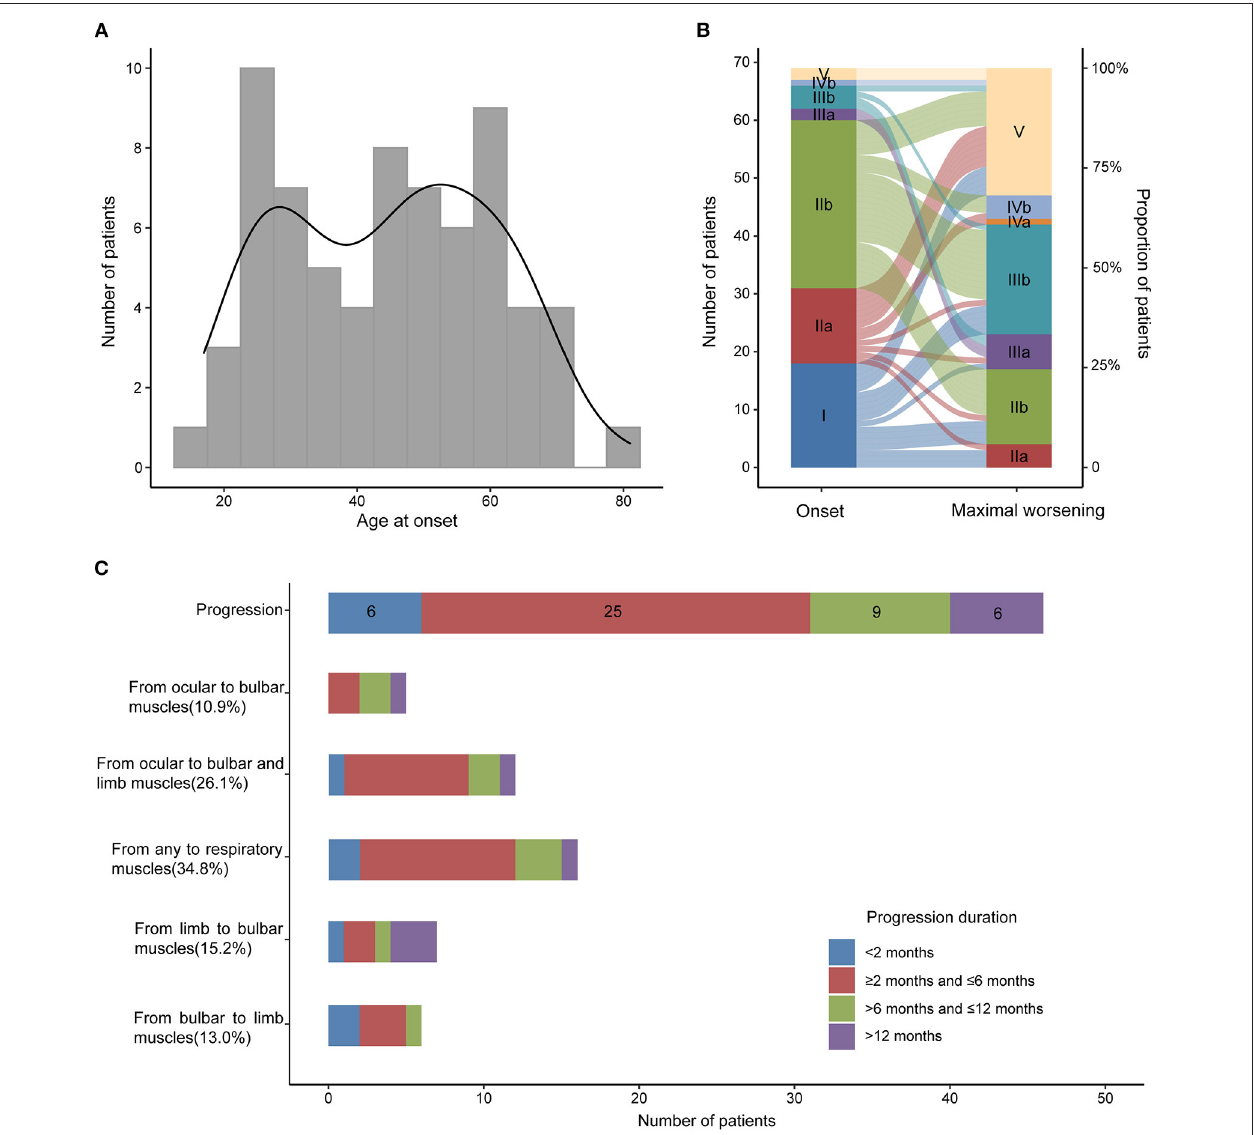
FIGURE 2 | Age at onset, MGFA classification at the onset and maximal worsening and disease progression in MuSK-MG. (A) Age at onset of 69 MuSK-MG patients in our cohort; (B) MGFA classification at the onset and at maximal worsening during the period from disease onset to the last follow-up; (C) Muscle involvement and disease progression of all the